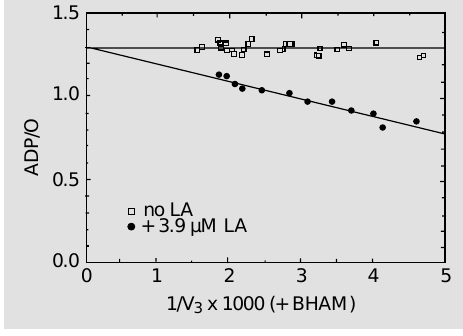
Figure 5 - Effect of 3.9 µM lino- leic acid (LA) on the ADP/O ratio plotted versus 1/V 3 . ADP/O and V